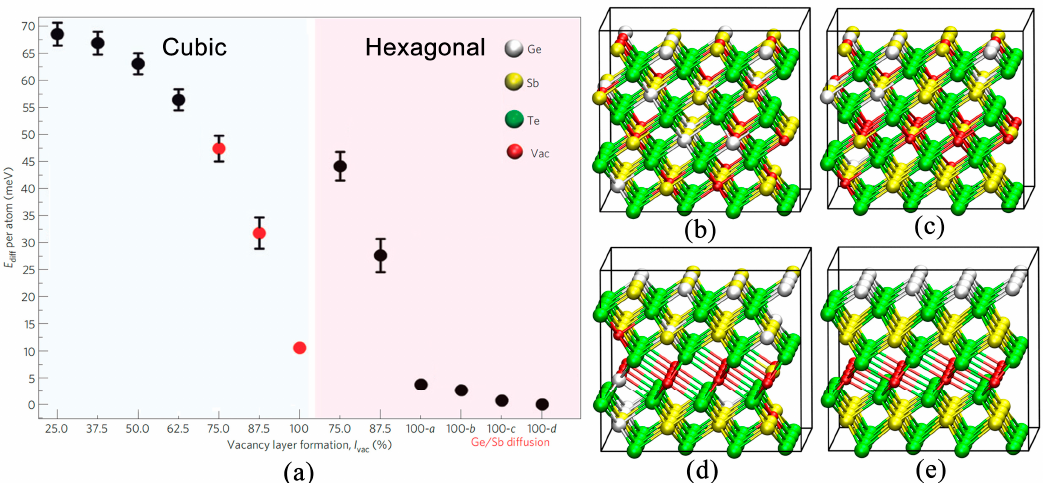
Figure 6. ( a ) The energy trend of Ge 1 Sb 2 Te 4 with the reduction of disorder and the formation of vacancy layers. The atomic vacancies migrate from cation-like layers to some specific cation-like layers (3 out of 24 atomic layers in a rocksalt Ge 1 Sb 2 Te 4 supercell model). The vacancy concentration on these layers increases from 25 to 100%. The red point at 100% in the cubic region indicates the ordered cubic phase with fully formed “vacancy layers”. Chemical Ge/Sb disorder on the cation-like layers is included; ( b – e ) The atomic structure of cubic and hexagonal GST models: ( b ) Cub-25% ( c ) Cub-50% ( d ) Hex-75% ( e ) Hex-100%- d. The four hexagonal models differ in the degree of chemical Ge/Sb disorder on the cation-like layers. Small red spheres indicate vacancies. Only parts of full models are shown, for the sake of clarity. Adapted with permission from Reference [15] © 2012 Nature Publishing Group.